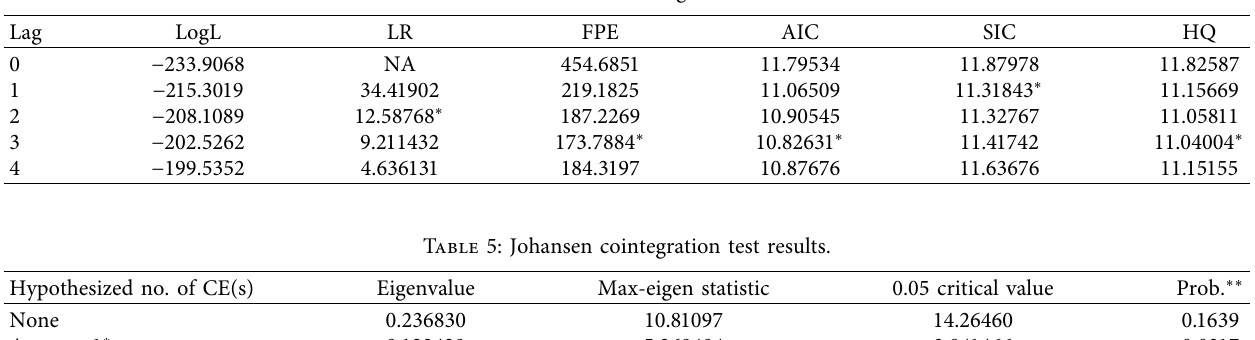
Table 4: Test of lag order.